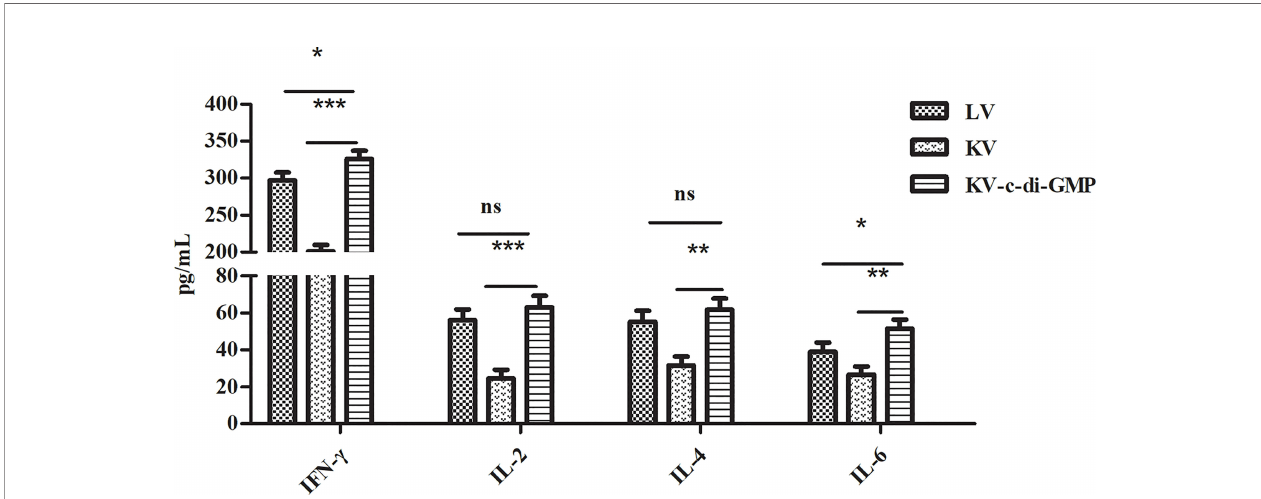
FIGURE 7 | Cytokine induction by the three vaccines in spleen cells isolated at 28 dpi and re-stimulated with PRV in vitro . Levels of IFN- g , IL-2, IL-4, and IL-6 by ELISA are expressed as mean ± standard deviation from three mice/group. Data represent three independent experiments. * P < 0.05; ** P < 0.01; *** P < 0.001; ns, no signi fi cant